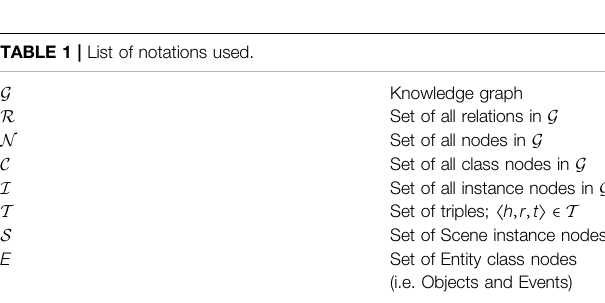
TABLE 1 | List of notations used. G Knowledge graph